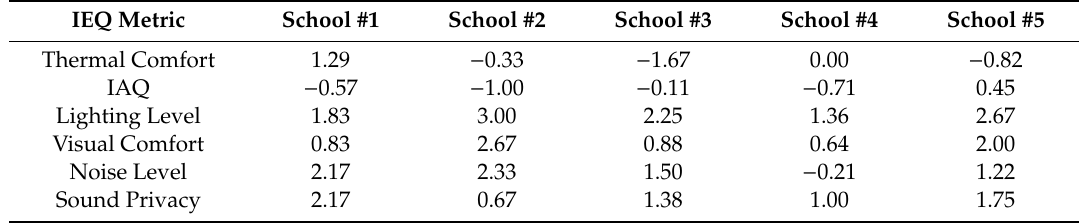
Figure 9. Overall Teacher Satisfaction by IEQ Metric. Table 13. Mean Teacher Satisfaction Rating by